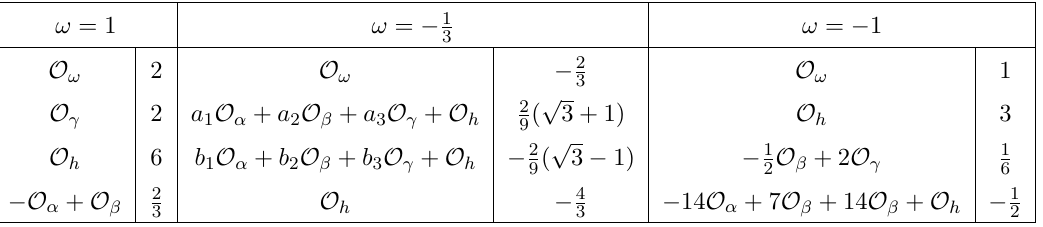
Table 2. Eigenvectors and eigenvalues of the RG (cid:13)ows at each of the (cid:12)xed points ! = 1 ; (cid:0) 1